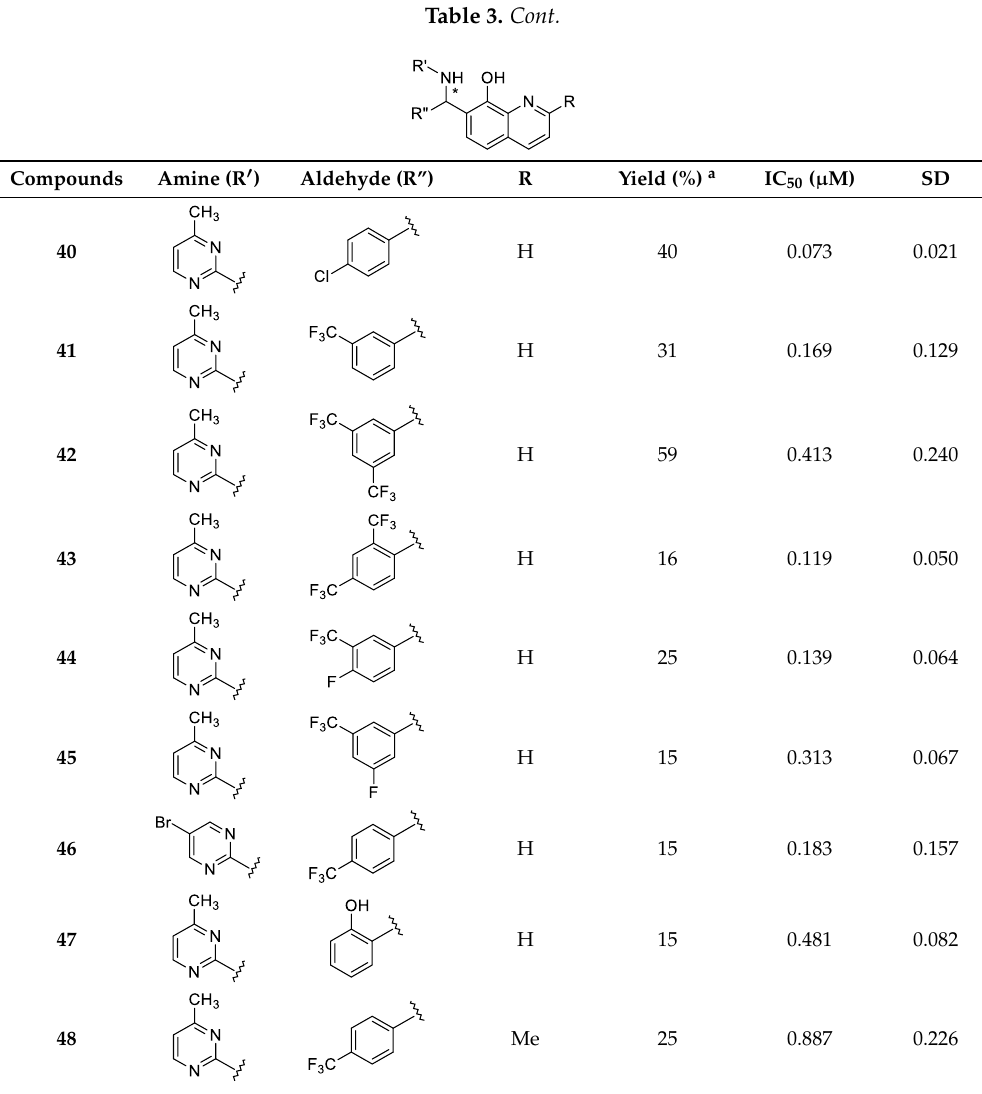
Table 3. Functionalization with several pyrimidines (Subclass 3).